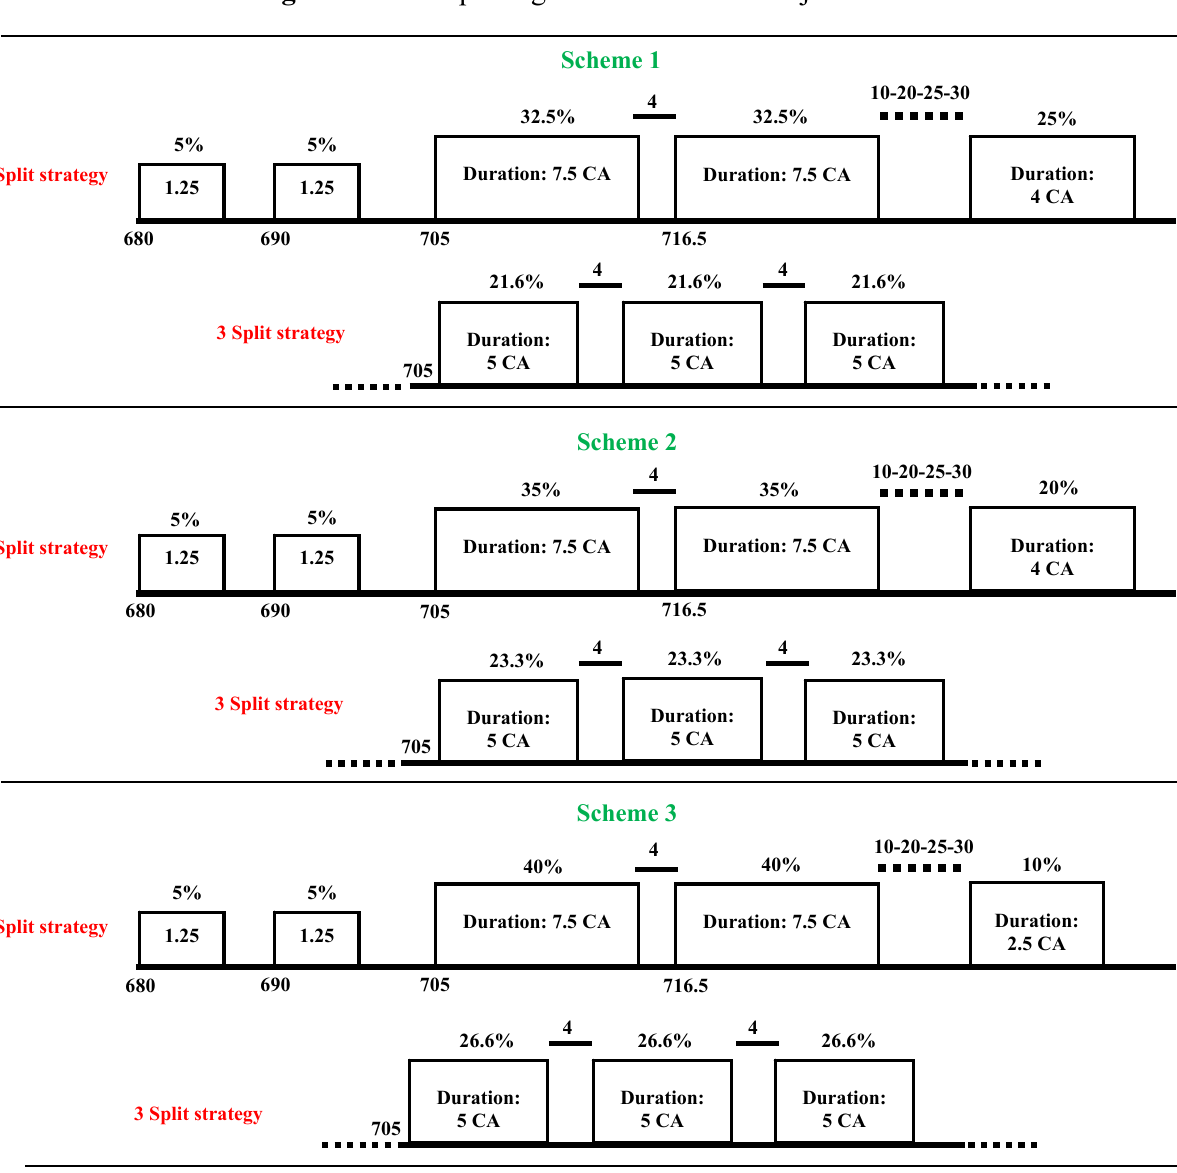
Figure 7. Main splitting into two and three